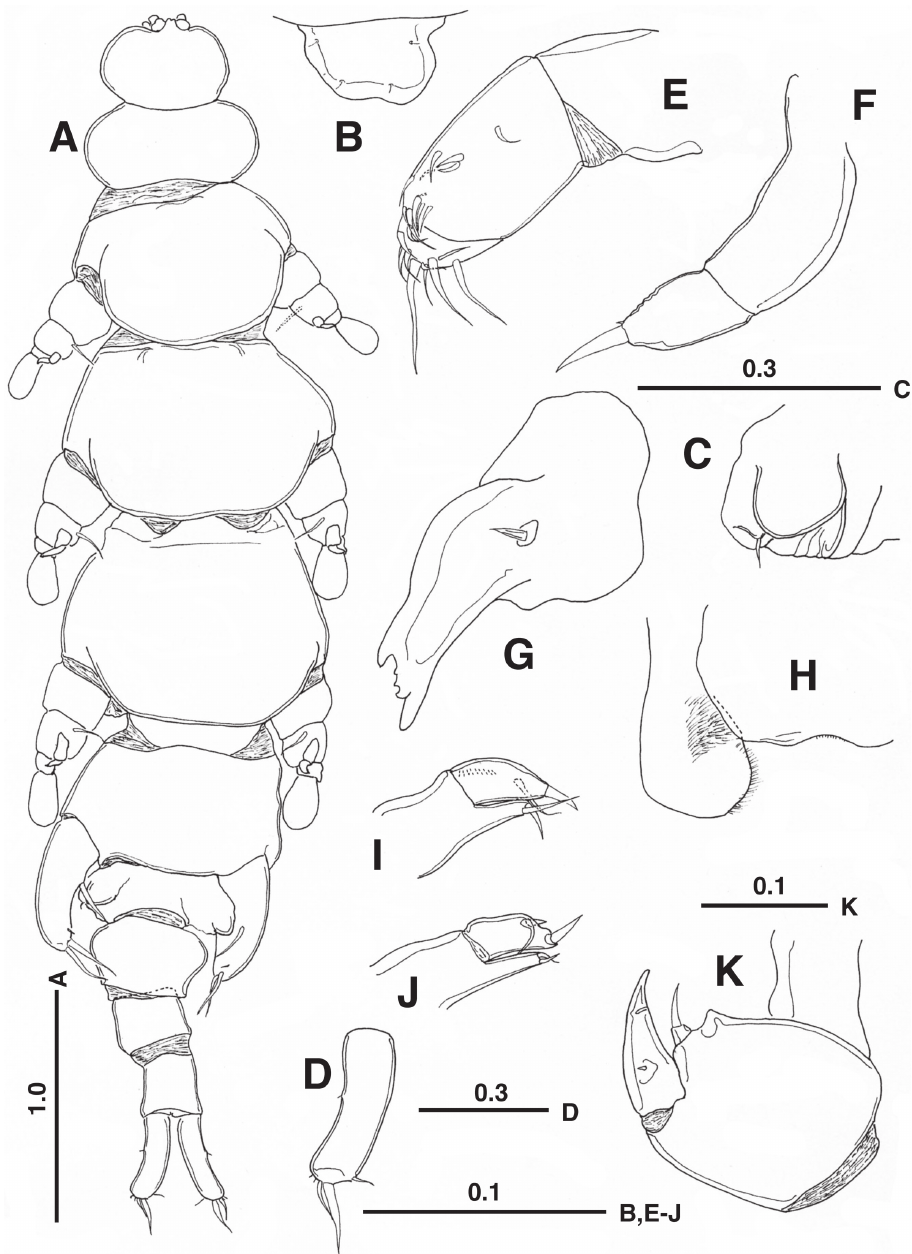
Figure 1. Enterognathus inabai sp. n. holotype female: A Habitus, dorsal view B Rostrum, dorsal view C Genital opening, right, dorsal view D Caudal ramus, left, dorsal view E Antennule F Antenna G Mandible h Labrum and paragnath, ventral view I Maxillule J Other maxillule K Maxilla. Scales in